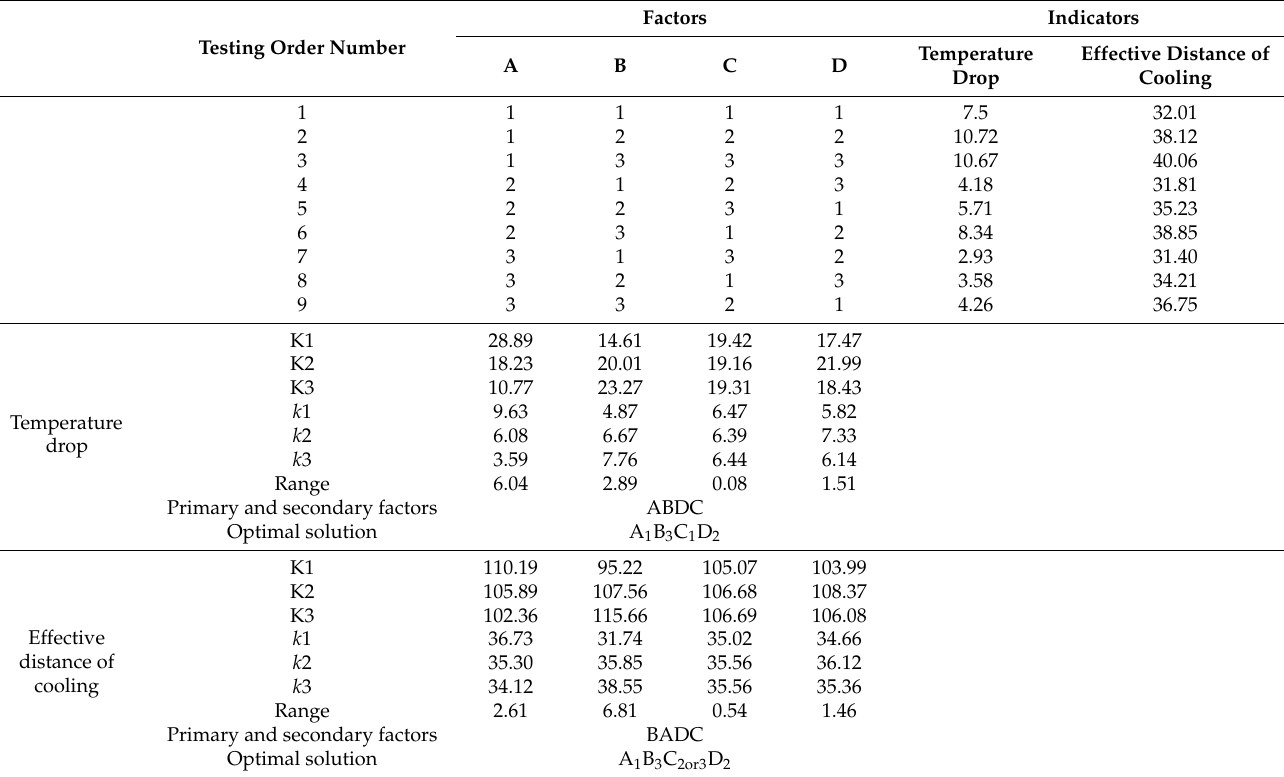
Table 7. Orthogonal experimental results and intuitive